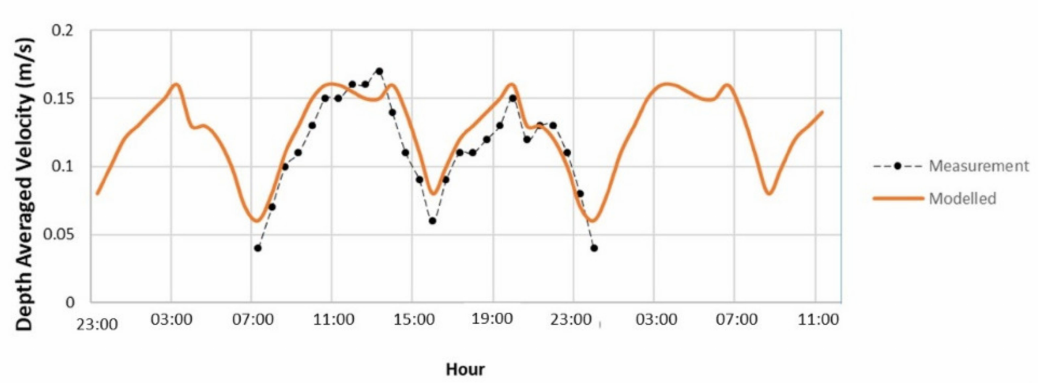
Figure 10. Comparison between modelled and measured water elevation.